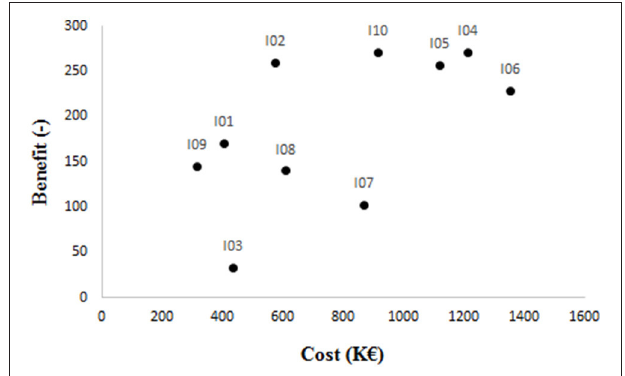
FIGURE 3 | Evaluation of possible intervention options.